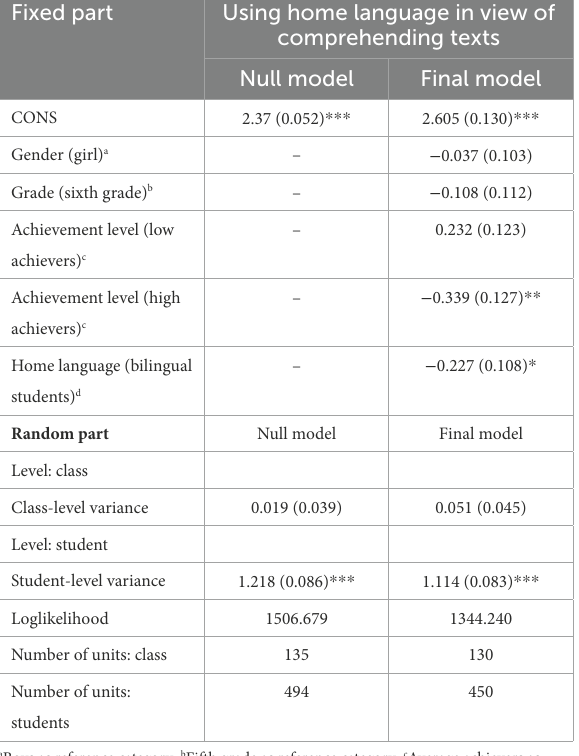
TABLE 6 Summary of the model estimates regarding the RCSQ subscale ‘using home language in view of comprehending texts.’ Fixed